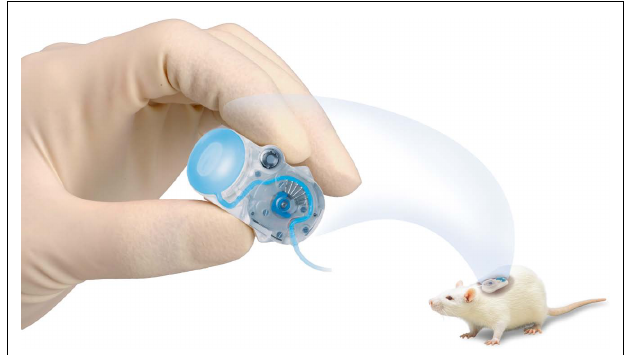
FIGURE 1 | iPRECIO ® SMP-200, 2nd generation implantable, refillable and programmable pump for small laboratory animals based on a mini-peristalsis flow infusion mechanism.